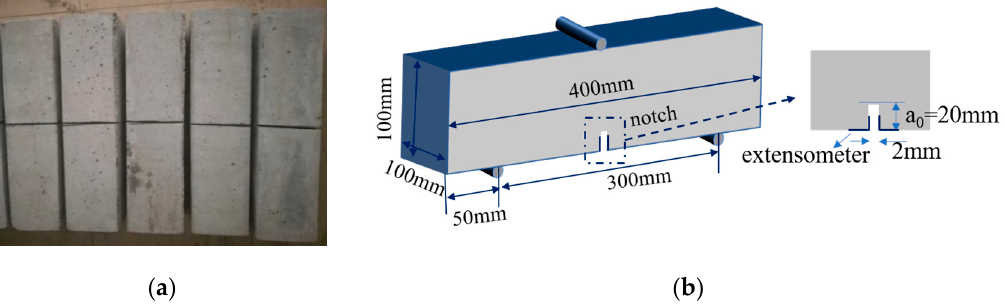
Figure 3. Fracture properties test of BFRCs. ( a ) fracture specimens; ( b ) test configuration.